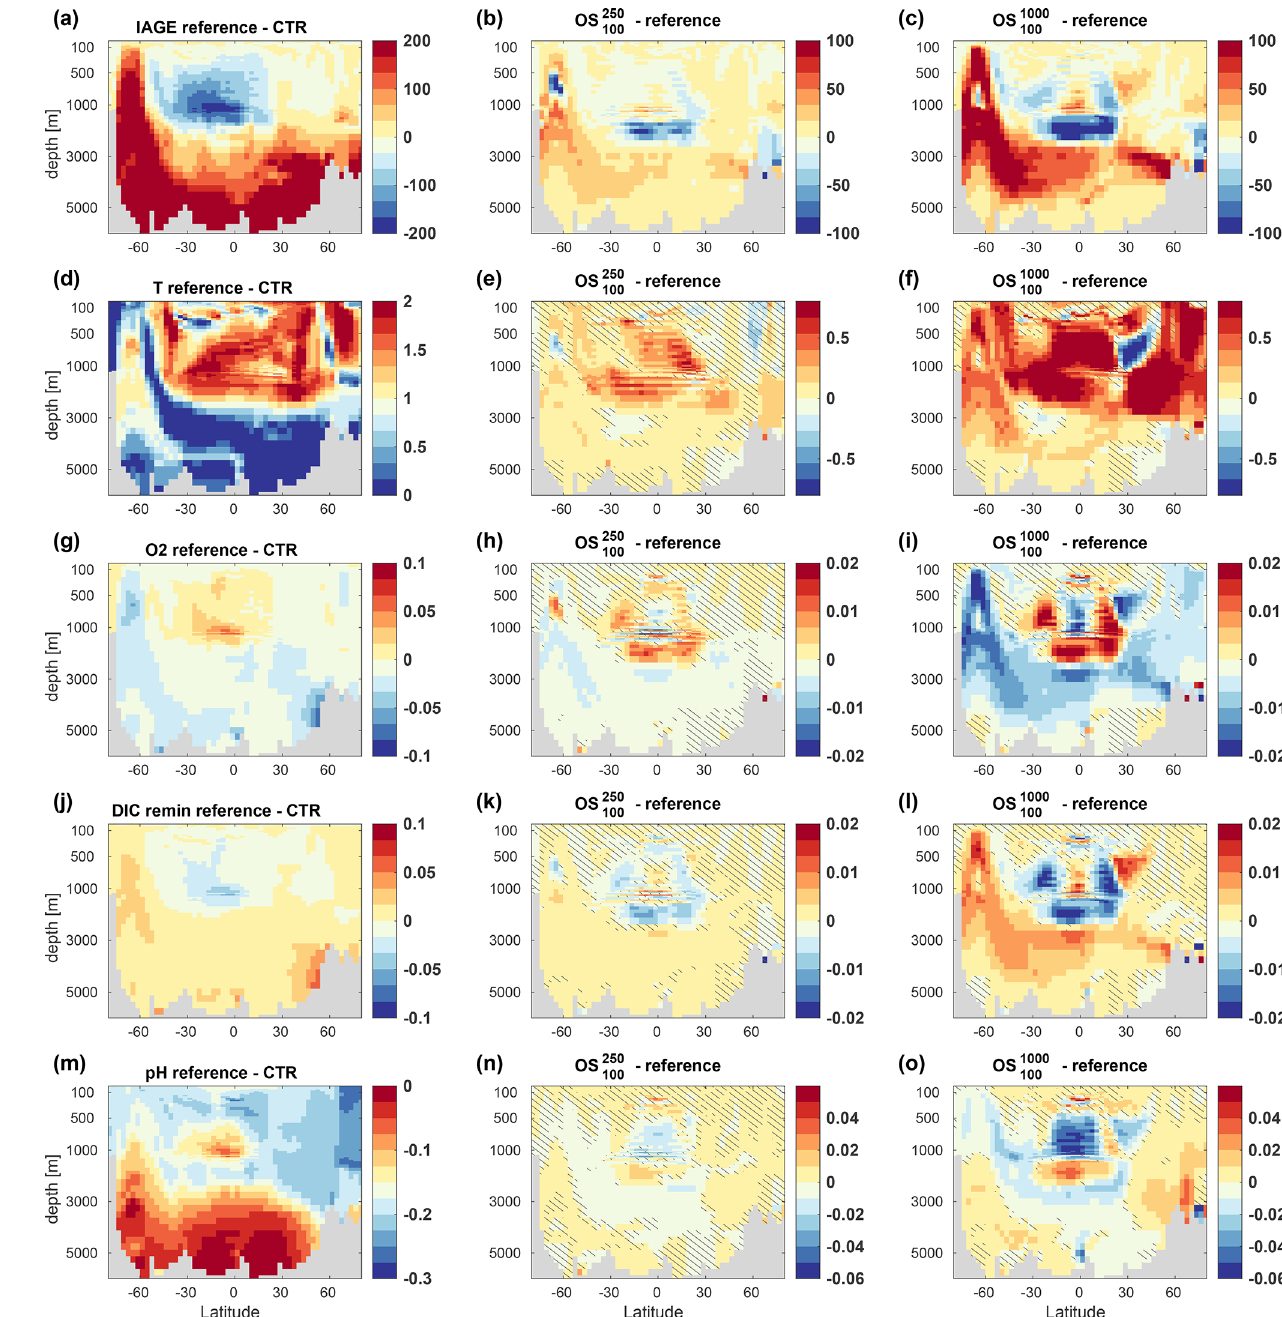
Figure A1. As Fig. 10 but for a zonal mean section through the Atlantic.